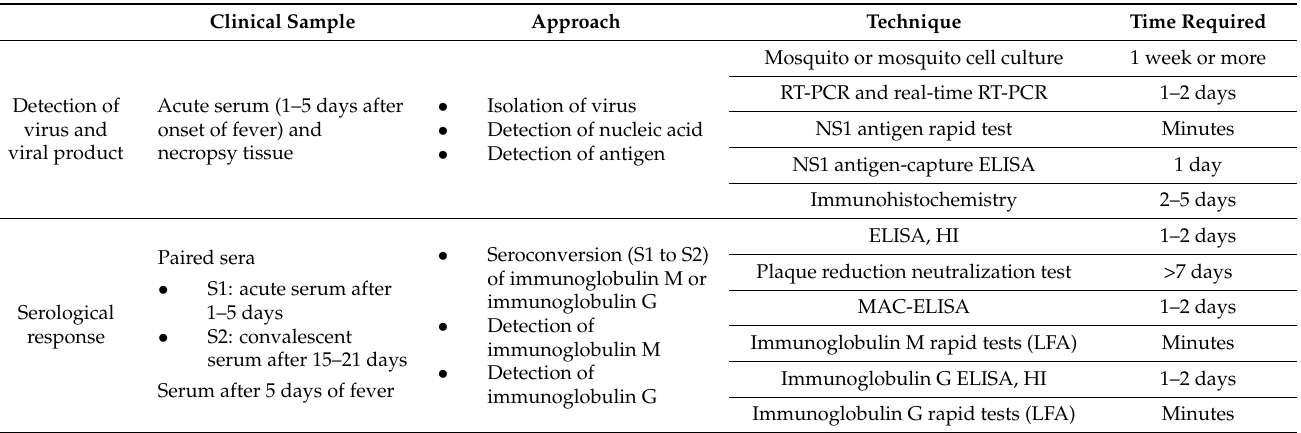
Table 1. Diagnostic methods for the detection of dengue infection, as adapted from the World Health Organization